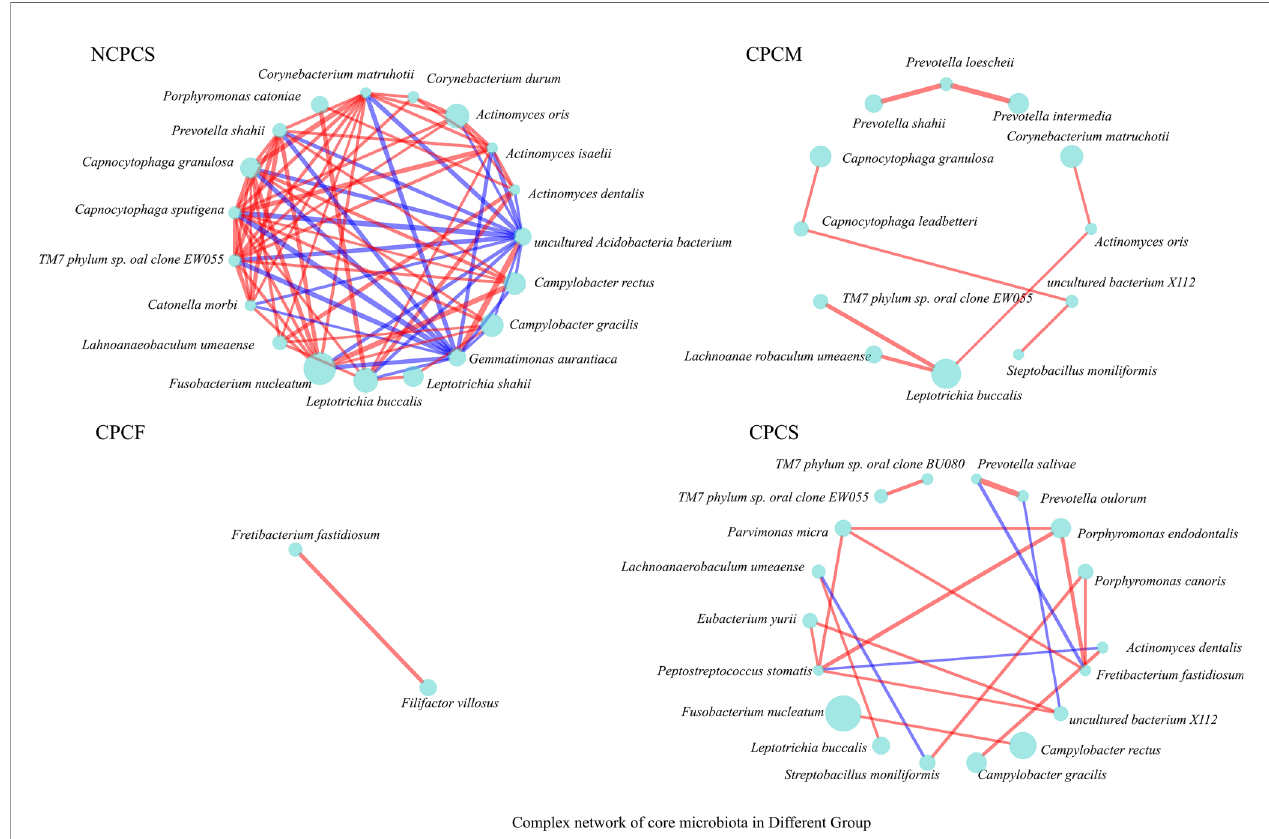
FIGURE 6 | The complex network of core SPM correlation in all groups. Genera with >0.5% relative abundance were chosen to establish correlation networks (P value ≤ 0.05, R-value ≥ 0.6). The circle size represents relative abundance. The red and blue lines suggest positive and negative correlations (proportional to line thickness),